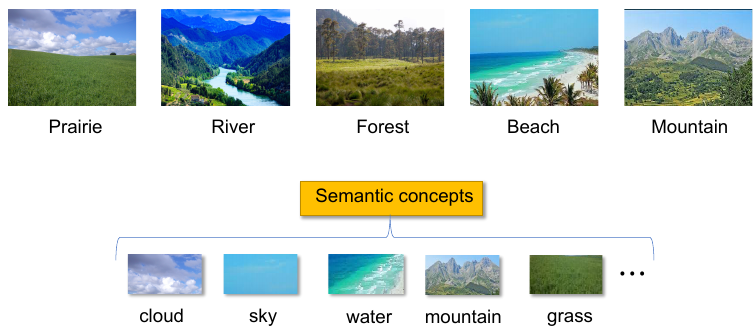
Figure 14. Natural scenes constituent